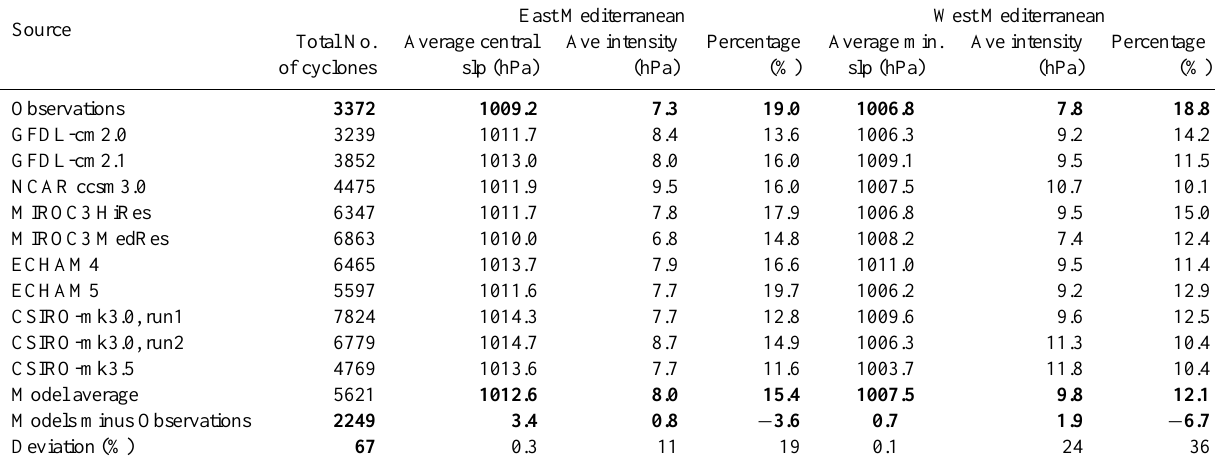
Table 2. Features of the cyclone occurrence statistics in the Mediterranean Basin. The methodology for cyclone detection is described in Sect. 3.1. The intensity of a cyclone is represented by the pressure difference between its center and the average over the 8 grid points at the corners and the sides of a 5 ◦ × 5 ◦ grid box around it. Note that the percentages (columns 5 and 8) are defined with respect to the “large